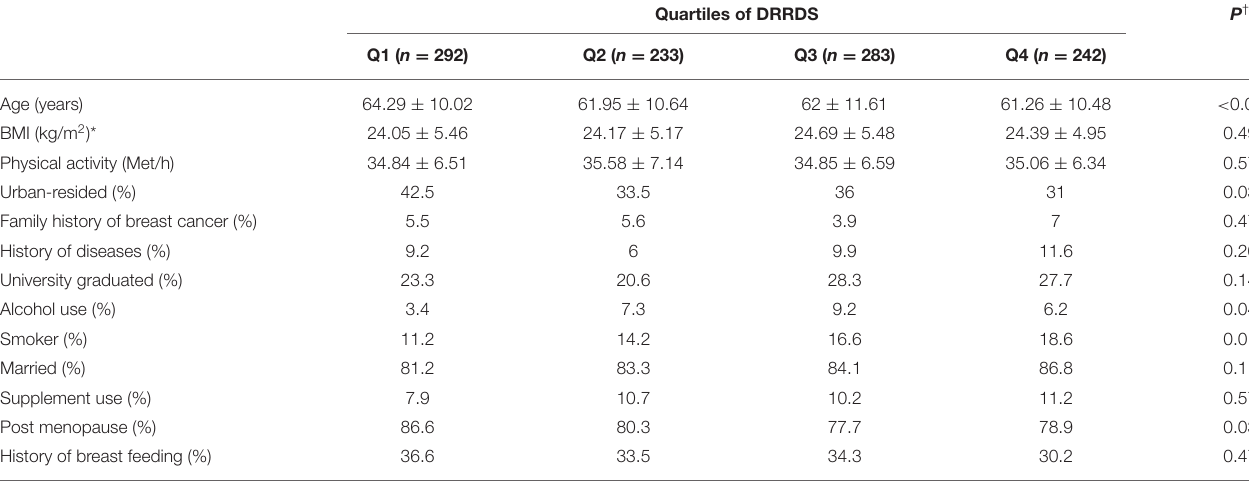
TABLE 1 | Characteristics of the study participants across subjects with and without breast cancer and also across quartile categories of DRRDS * .